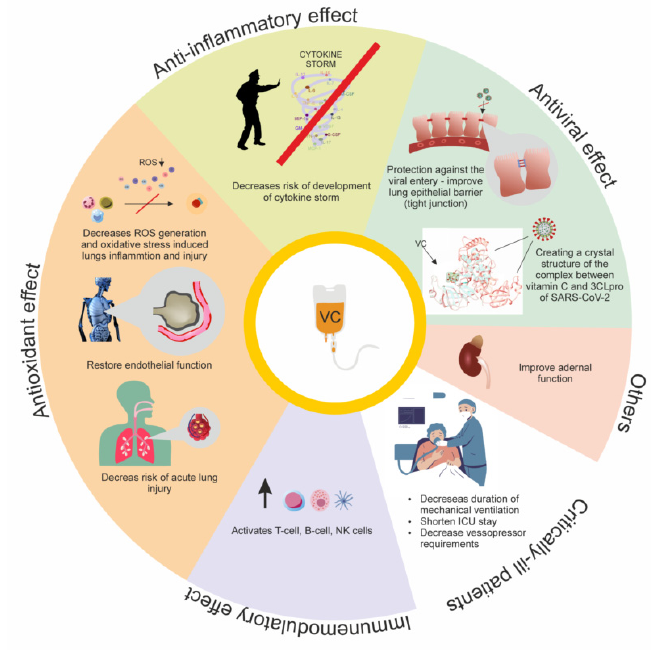
Figure 3. The effect of vitamin C in SARS-CoV-2 infection.